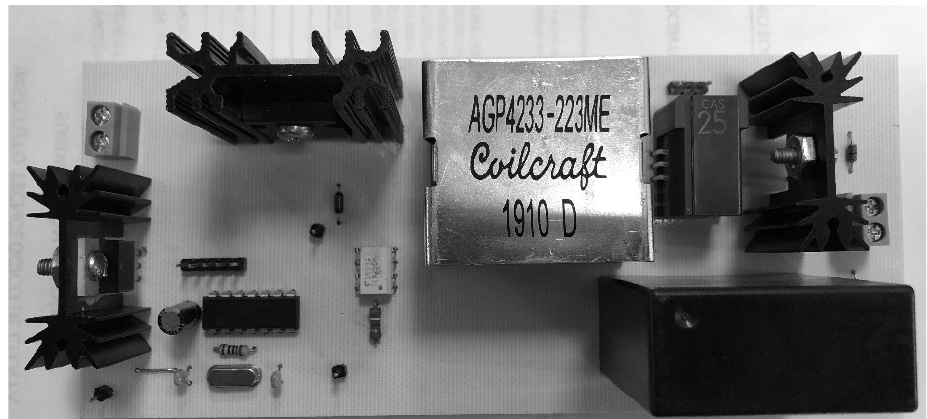
Figure 9. PCB used for the experimental tests presented in this paper.